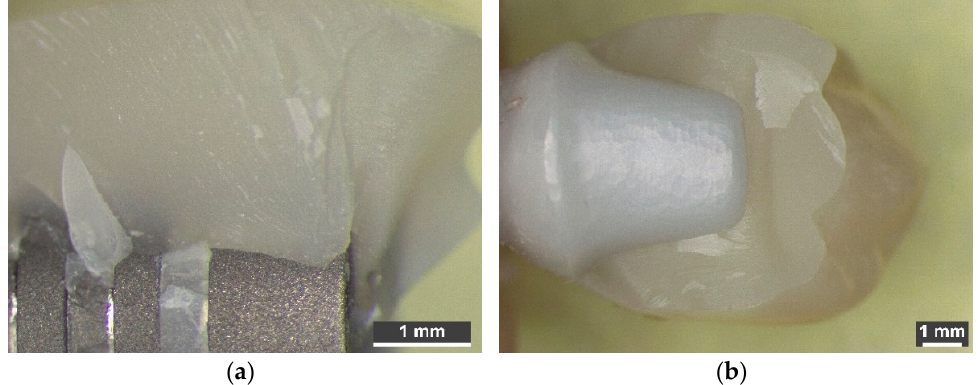
Figure 8. Fracture modes of the two groups: ( a ) group 1, with debonding of the NCR material from the titanium abutment, and ( b ) group 2, with partial fracture of the NCR material without failure of the zirconia abutment.